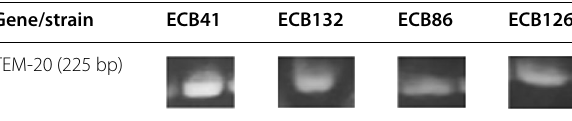
Table 2 Antibiotic-resistant gene blaTEM-20 expression in ESBL -E.